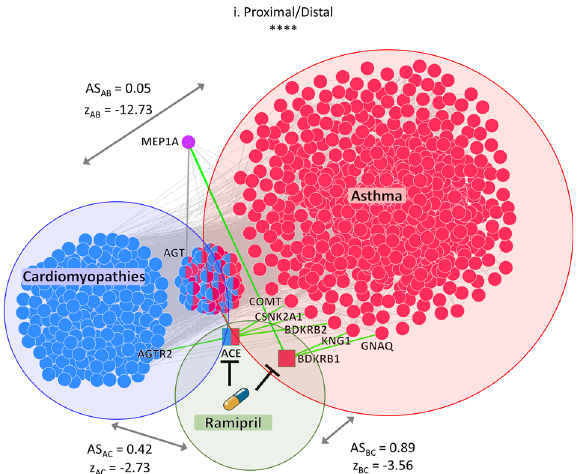
Fig. 8 Interaction network of drug targets inducing severe adverse side-effects. Inferred mechanism-of-action network for a selected triplet: cardiomyopathies (disease A), asthma (side-effect B), and ramipril (drug C). The z AC and z BC denote the z -score normalized values of network proximity between the targets of the drug (C) and the genes associated with the disease (A) and with the side-effect (B), respectively; while z AB denotes the z -score normalized value of network proximity between the genes associated with the disease (A) and with the side-effect (B). AS AC , AS BC , and AS AB are the corresponding adjusted similarity values. In the interaction network, red circles refer to side-effect-associated genes, blue circles refer to disease-associated genes, squares refer to drug targets (blue and/or red colored if they are shared with the disease and/or side-effect module), and violet circle refers to a fi rst nearest neighbor (that is not disease or side-effect-associated gene) of the drug targets able to connect the drug module to the disease module in the human interactome. Green edges refer to connections between the drug targets and their fi rst nearest neighbors in the human